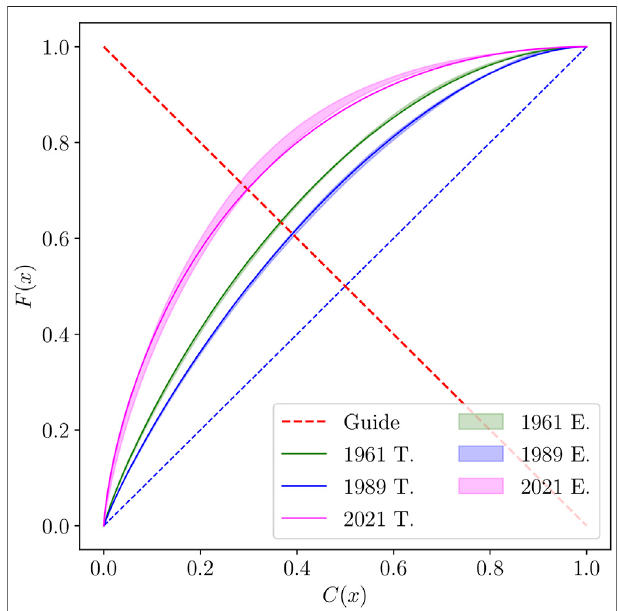
FIGURE 6 | Experimental and theoretical Lorenz curves for the years 1961, 1989, and 2021. The shaded region indicates the region spanned by the experimental results for different weight parameter sets. The theoretical curves were calculated from the fi tted distributions, and are plotted with the continuous bold line.